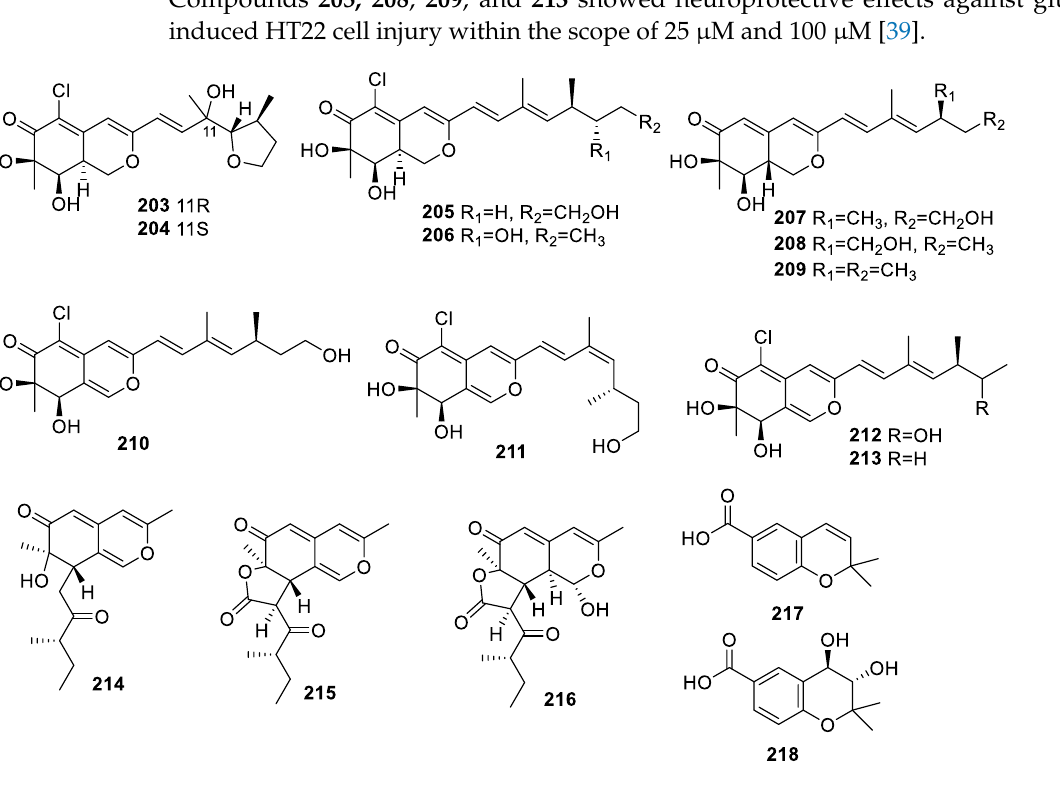
Figure 8. Chemical structures of pyranyl derivatives ( 203 – 218 ).